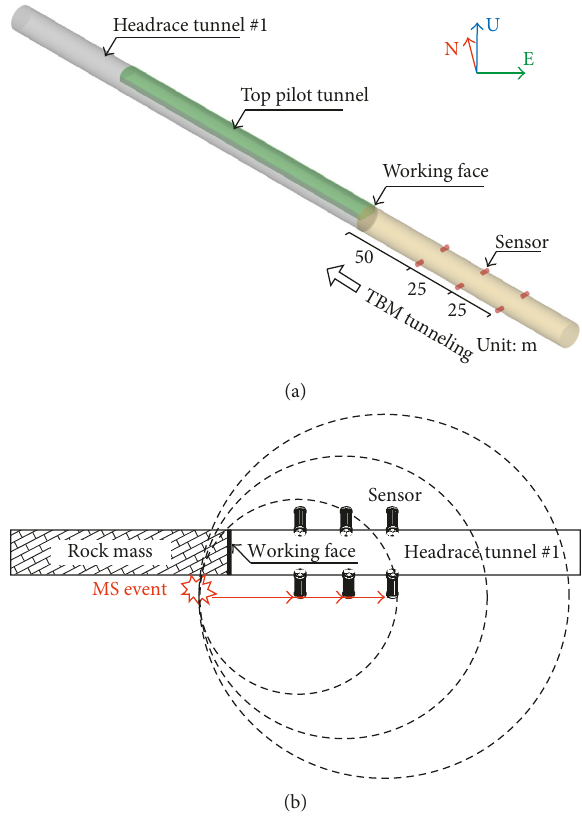
Figure 10: (a) The layout scheme and (b) source location mode of the following sensor